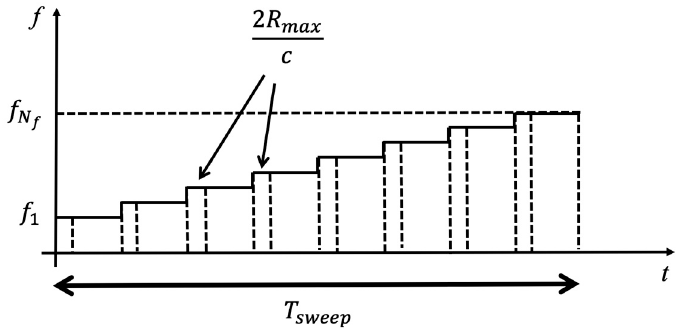
Figure 12. Step Frequency modulation.